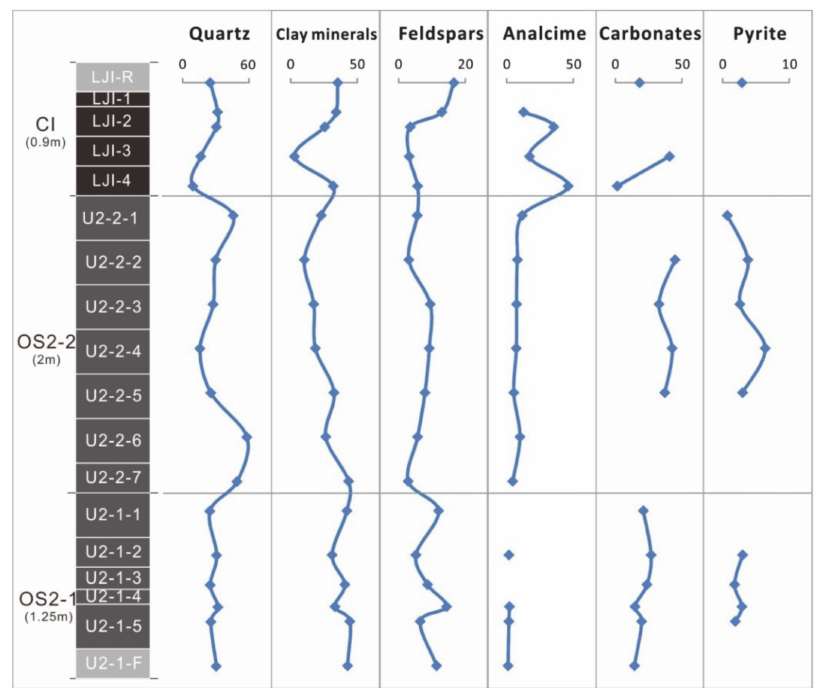
Figure 2. Vertical variations of quartz, clay minerals, feldspar, analcime, carbonate minerals, and pyrite (wt%) in C1 and OS2 of Liangjia Coal Mine. The absent values of analcime, carbonate minerals and pyrite are also determined by the XRD + Siroquant, but are below the detection limit of XRD; The horizontal lines separate C1, the upper and the lower part of OS2 (OS2-2,